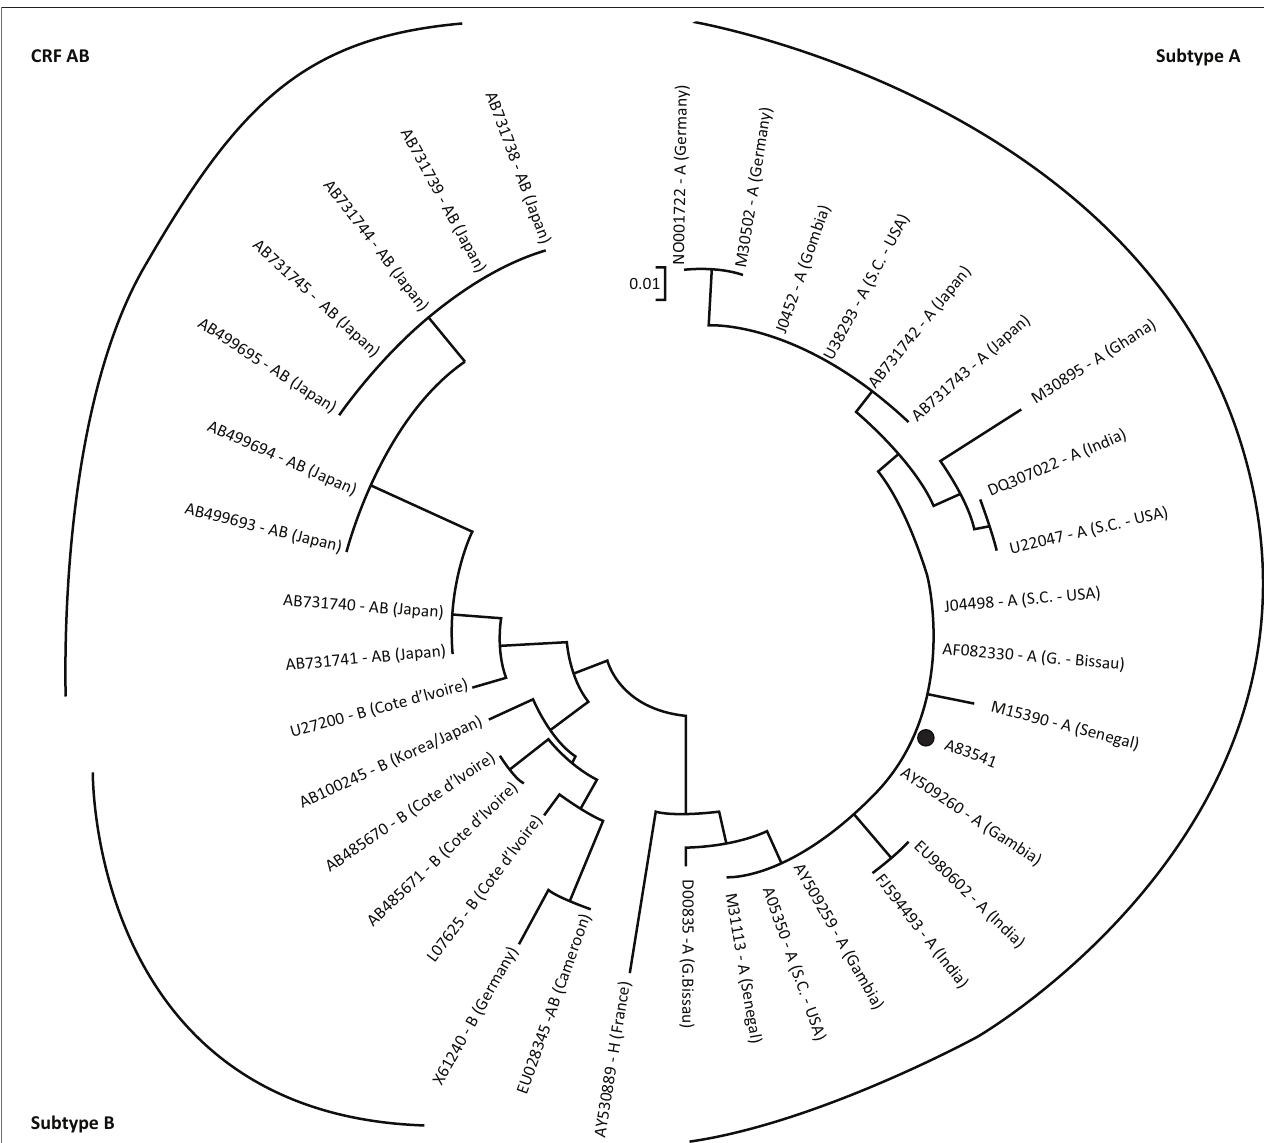
FIGURE 3: Phylogenetic tree showing the sequence of the known human immunodeficiency virus-2 sample that was positive on in-house polymerase chain reaction (labelled with a black dot). This sequence clustered with subtype A human immunodeficiency virus-2